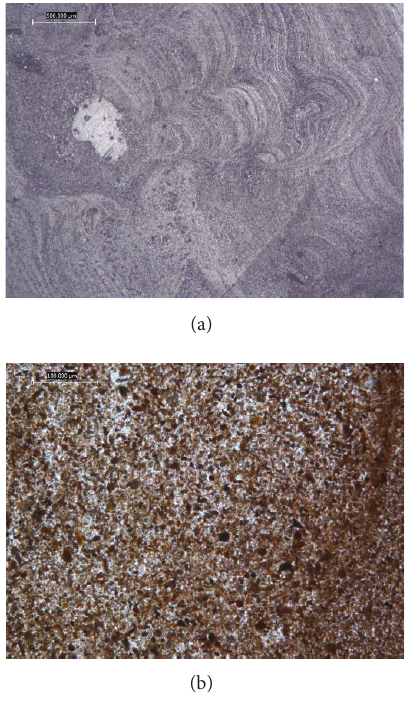
Figure 7: (a) Photomicrograph of superheater deposit. Reflected light images showing curvilinear layering. (b) Photomicrograph of anhydrite CaSO 4 /iron oxide Fe 2 O 3 layer—in transmitted polarised light-white anhydrite and dark brown iron oxide grains.